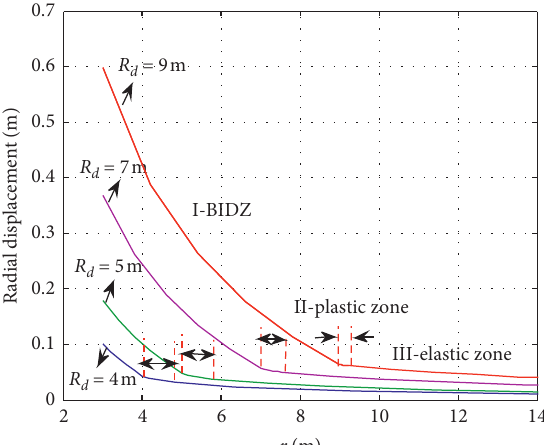
Figure 8: Displacement change of tunnel under various damage ranges ( c � 0 and b � 0).